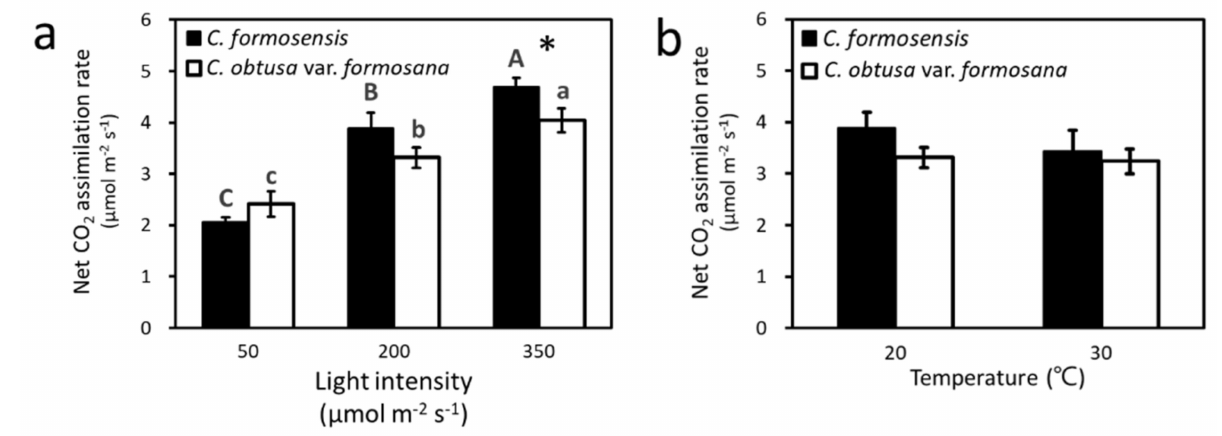
Figure 1. Net CO 2 assimilation rates of C. formosensis and C. obtusa var. formosana saplings grown at ( a ) different light intensities under 20 ◦ C, and ( b ) different temperatures under 200 µ mol m − 2 s − 1 light intensity. Bars (mean ± s.e., n = 9) with different letters denote significant difference in means among the three light intensities in each species. Bars with a star indicate significant difference in means between two species at that light intensity (*, p <